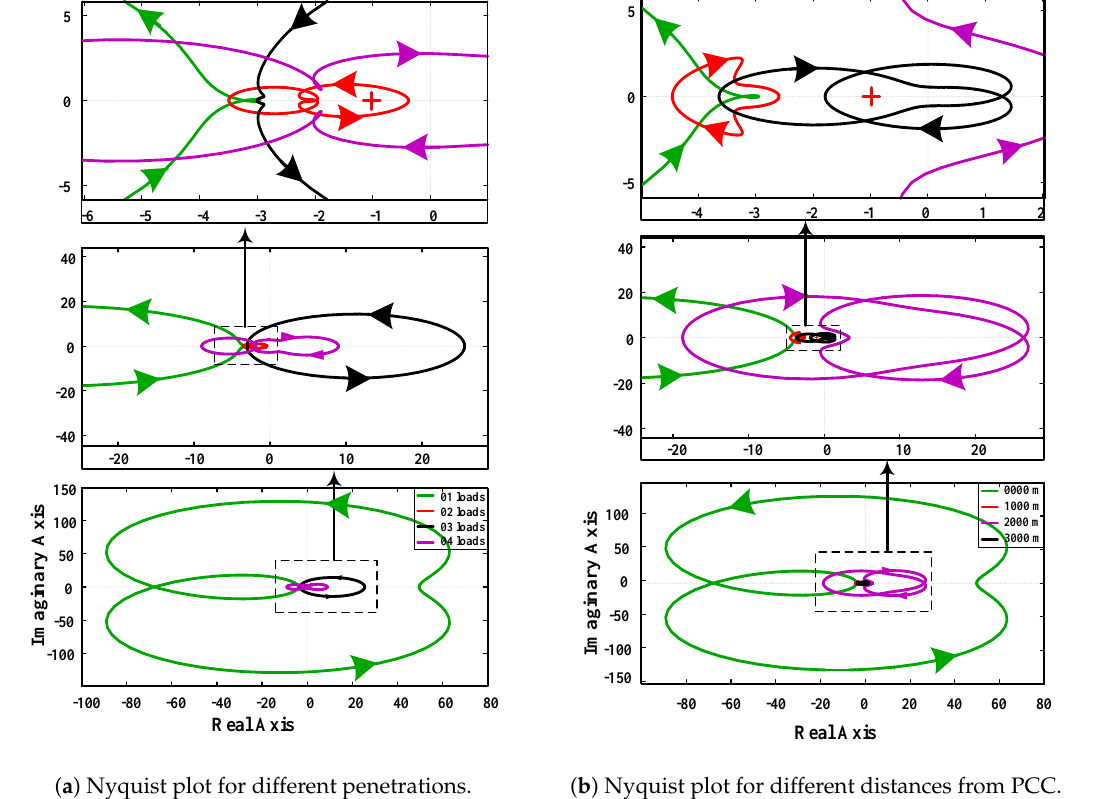
Figure 9. Nyquist plot for different penetrations and